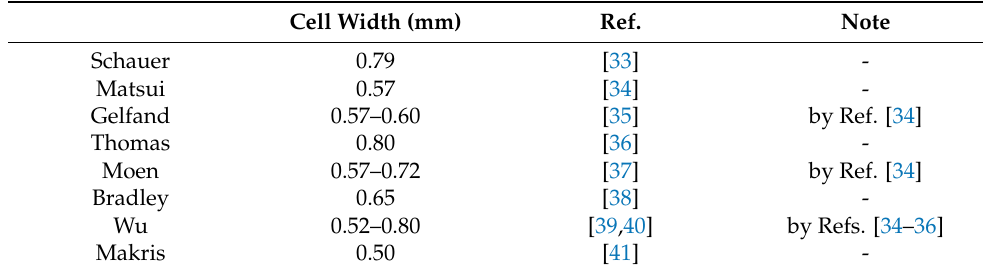
Table 2. Detonation cell width at 0.1 MPa and 298